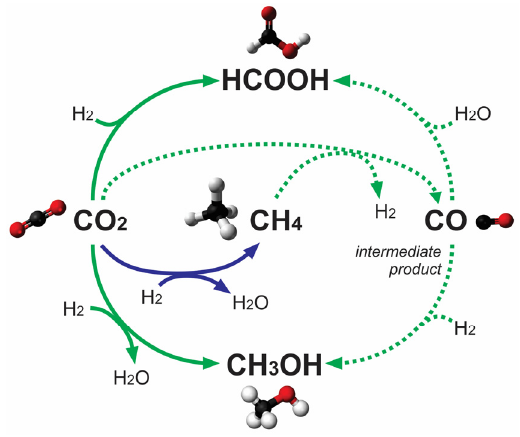
Figure 8. The time-dependent yield of ( a ) CH 4 evolution, ( b ) CH 3 OH formation, and ( c ) HCOOH formation over 1 wt % Pt/CuAlGaO 4 photocatalyst under different H 2(g) partial pressures in gas-liquid phase reactor. Lines are not based on a kinetic model and are presented for eye-guiding only.